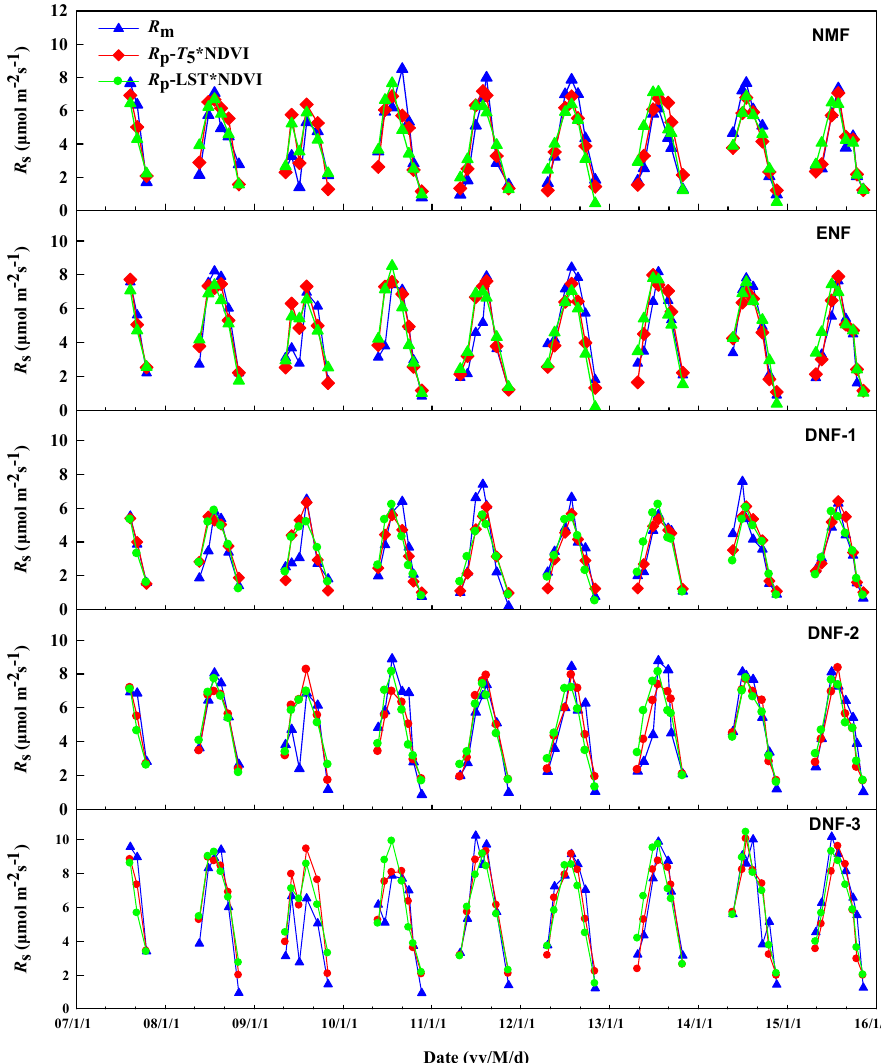
Figure 3. Seasonal variations of soil respiration measured ( R m ) and predicted ( R p ) by model five based on in situ soil temperature and NDVI ( R p – T 5 *NDVI) or nighttime LST and NDVI ( R p –LST an *NDVI) for the five study sites.